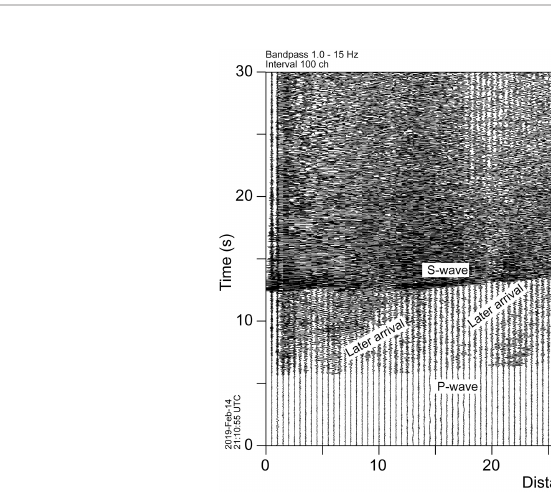
FIGURE 3 | Time – distance pro fi le of phase data for a local earthquake recorded by the DAS system. The phase data of each channel were fi ltered from 1 to 15 Hz to increase the S/N ratio. Each trace was plotted using the same amplitude scale. The horizontal axis is distance from the coast, and the vertical axis shows time. A position of the seismic station SOB3 in the cable observation system is indicated. There are 10,000 channels in the DAS measurement, and only 100 channels are plotted at an interval of 100 channels. The arrival of P-waves and S-waves are clearly seen. In addition, other seismic arrivals can be recognized. The earthquake corresponds to event No. 8 in Figure 2